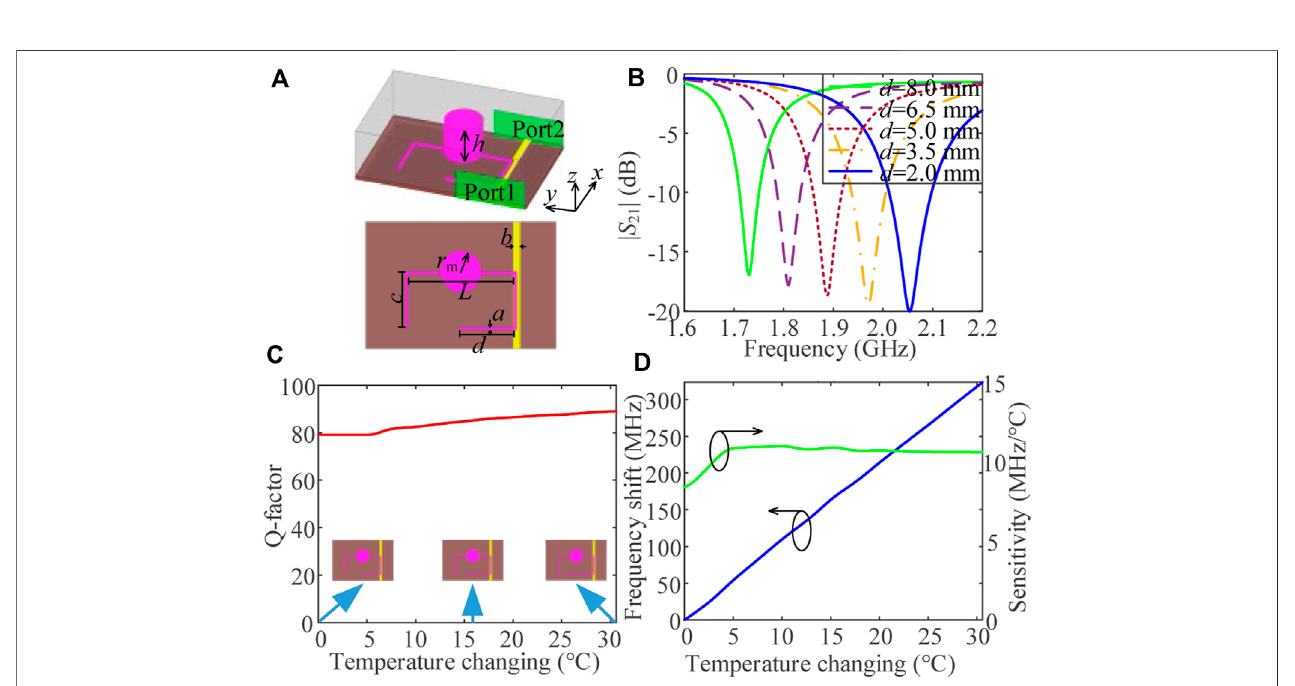
FIGURE 3 | (A) 3D view of the modi fi ed Hg-Fano resonator with port setting in modeling environment and top view with parameters de fi nition, (B) numerical transmissioncurvesunder different parameter d values, and (C,D) the calculated Q-factor, resonantfrequency shift, and temperature sensing sensitivity as afunction of temperature